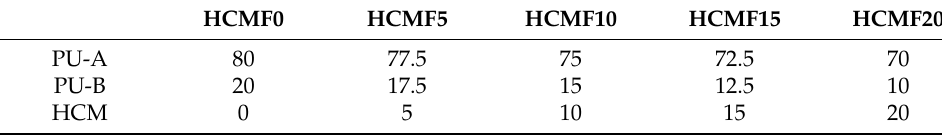
Figure 1. Illustrative diagram of the preparation process HCMF composites. Table 1. Denotation and specification of HCMF composites.